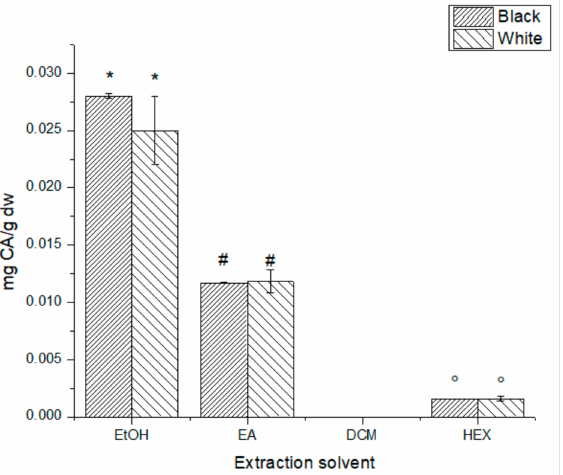
Figure 6. Caffeic acid content for all extracts tested. *, #, ◦ No significant difference ( p > 0.05). Rosmarinic acid, a caffeic acid derivative, showed a significantly higher concentration content in the ethanolic extracts (Figure 7), with the W-SPLE extract having the highest concentration at 24.9 ± 0.4 mg RA/g dw. The less polar extracts have no